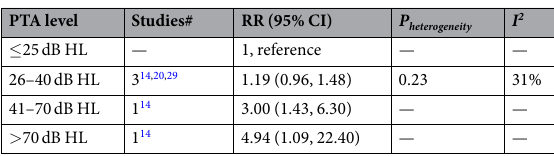
Table 2. Association of severity of peripheral hearing loss with incident cognitive impairment. Abbreviations: CI = confidence interval, PTA = pure-tone average, RR = relative risk, dB HL = decibels hearing level.